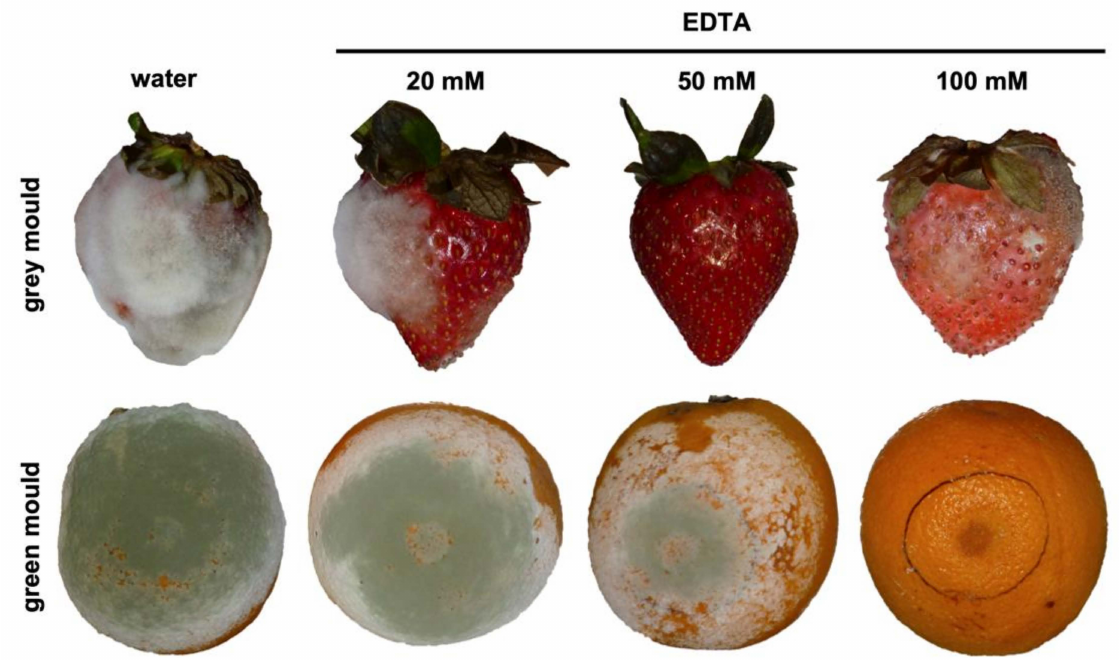
Figure 7. Disease-suppressing effect of EDTA on strawberry grey mould and citrus green mould. The fruits were inoculated with spore suspensions of B. cinerea (grey mould) or P. digitatum (green mould) as described in Material and Methods and were treated with different EDTA solutions 8 h after pathogen inoculation of the pathogen. Pictures were taken 5 (grey mould) or 6 (green mould) days after